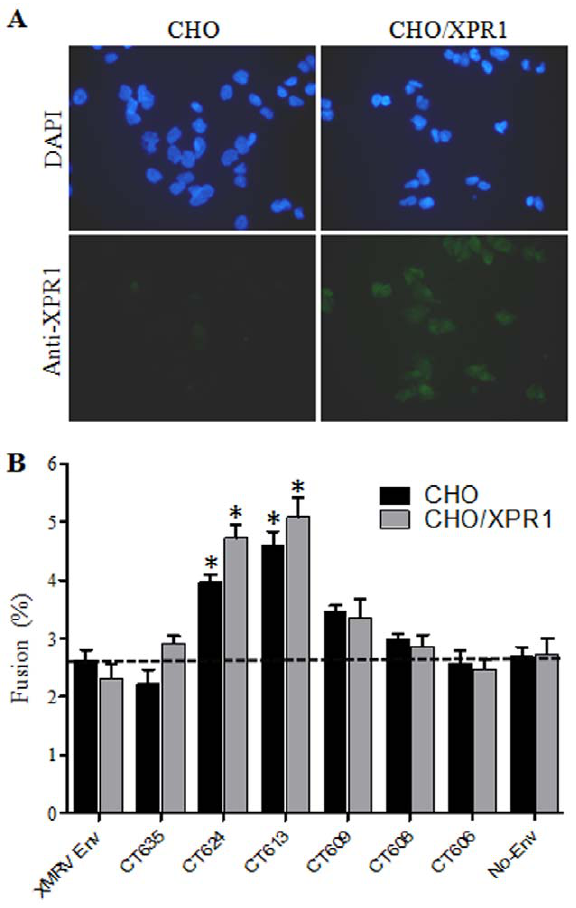
Figure 6. Cell-cell fusion activities of XMRV Env and mutants in CHO or CHO cells expressing XPR1. (A) Immunostaining of CHO and CHO/XPR1 cells. Cells were fixed, permeabilized, stained for XPR1 using anti-XPR1 and FITC-coupled secondary antibodies, and counter- stained using DAPI. (B) XMRV Env truncation mutants can induce cell- cell fusion in non-permissive CHO cells. Effector 293T/GFP cells expressing indicated XMRV Env were co-cultured for 6 h with target CMTMR-labeled CHO or CHO cells expressing XPR1 (CHO/XPR1) and analyzed for fusion by flow cytometry. Shown are the averages of 3 , 6 independent experiments 6 S.D. * indicates p ,